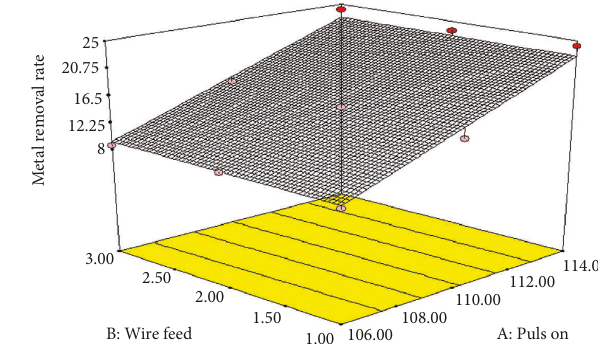
Figure 10: Effect on the PT